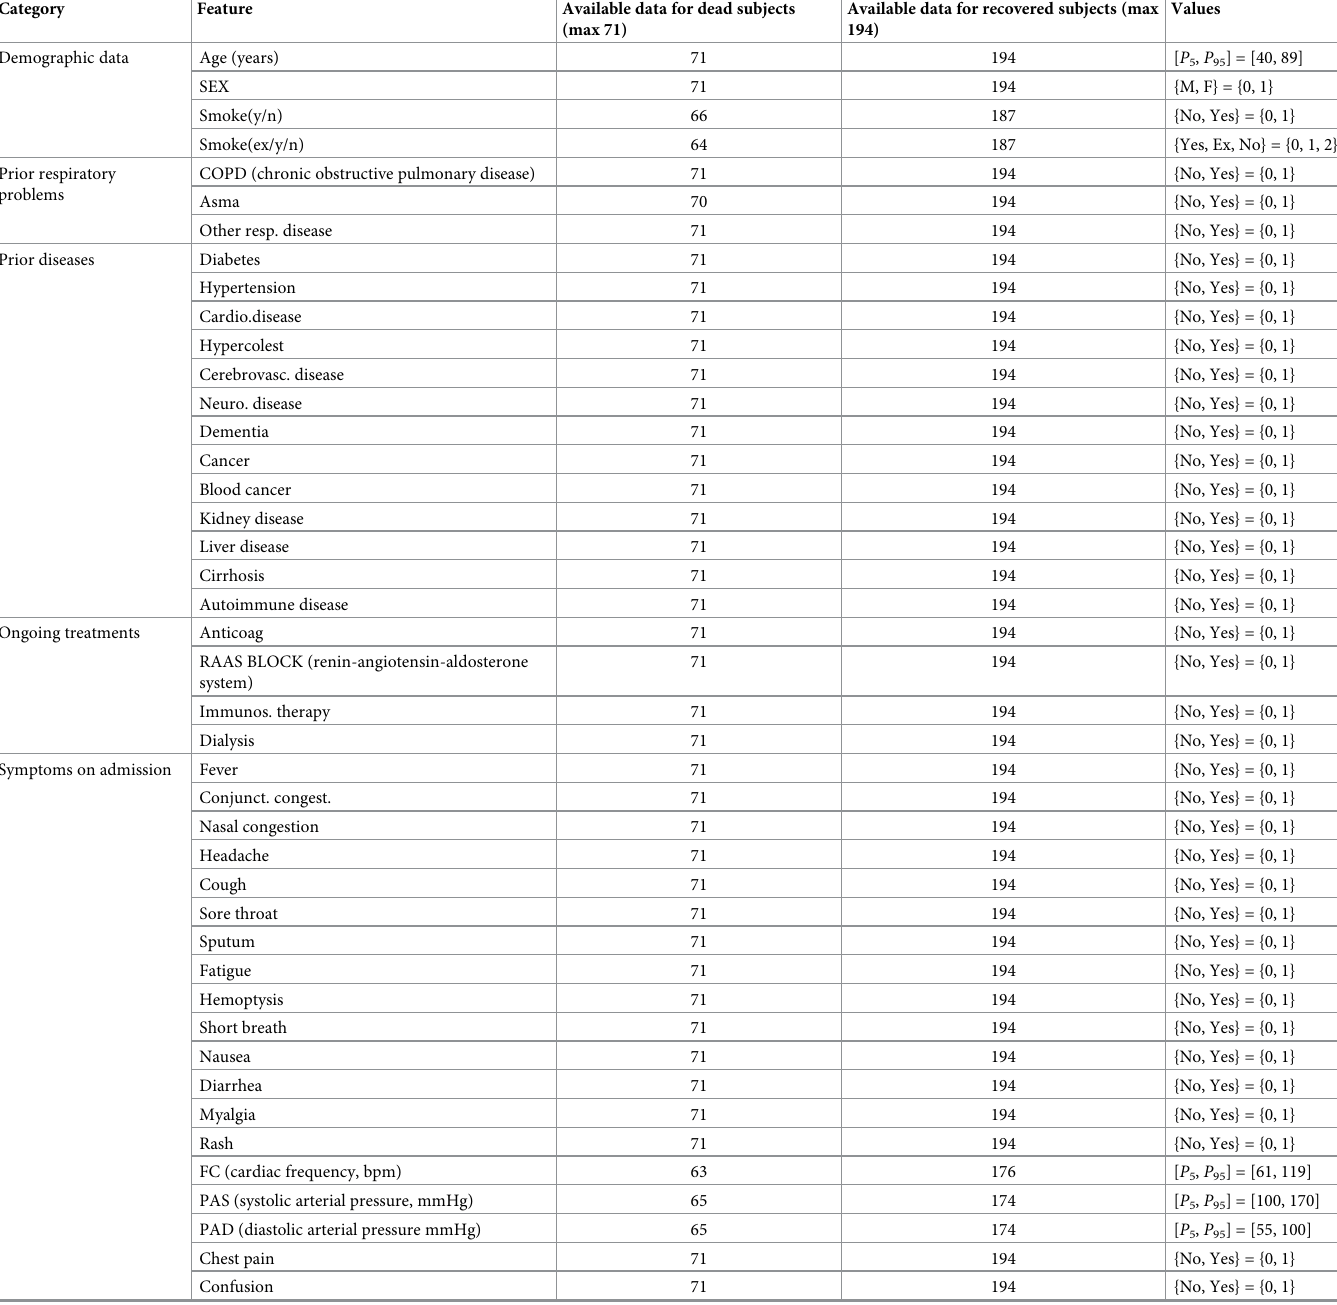
Table 1. Summary of the dataset features. In this table the 63 features analyzed in this work, reported in the second column, are grouped into 6 classes, listed in the first column. The third and fourth columns show the feature occurrence in the dataset in dead and recovered subjects, respectively. The last column reports a description of the feature values: for continuous variables the 5th and the 95th percentiles indicated as [ P 5 , P 95 ] are reported, while for categorical variables their values are reported within curly brackets.